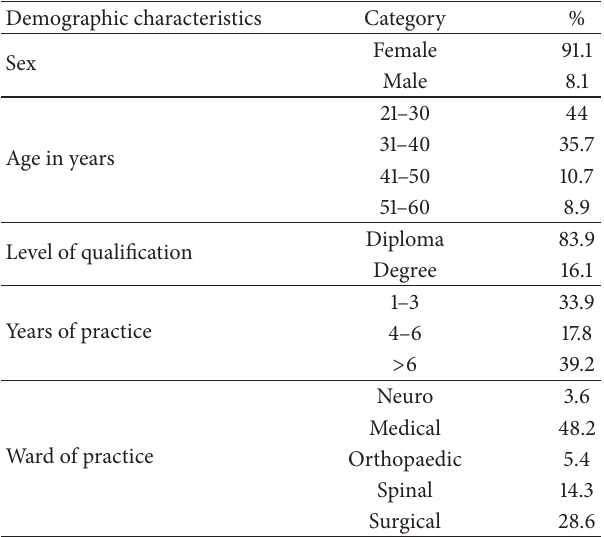
Table 1: Demographic characteristics of study